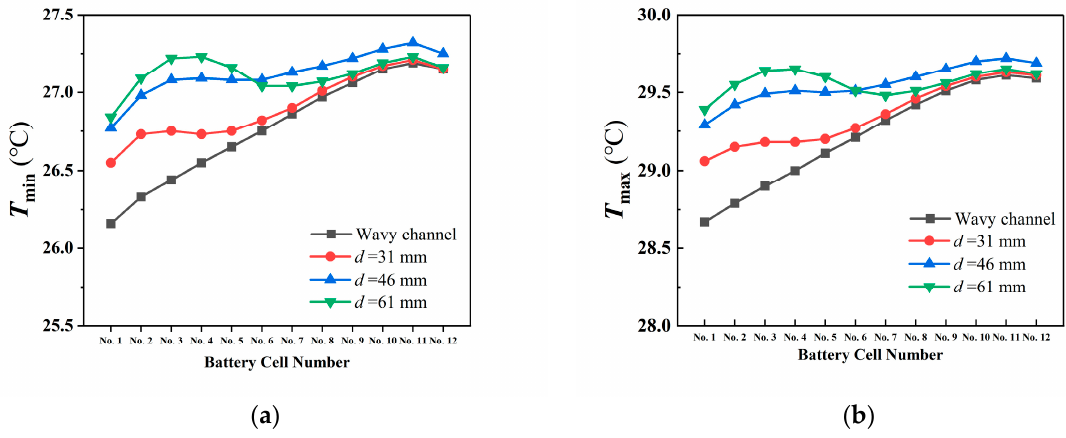
Figure 10. Temperature of each battery under different configurations: ( a ) T min and ( b ) T max .